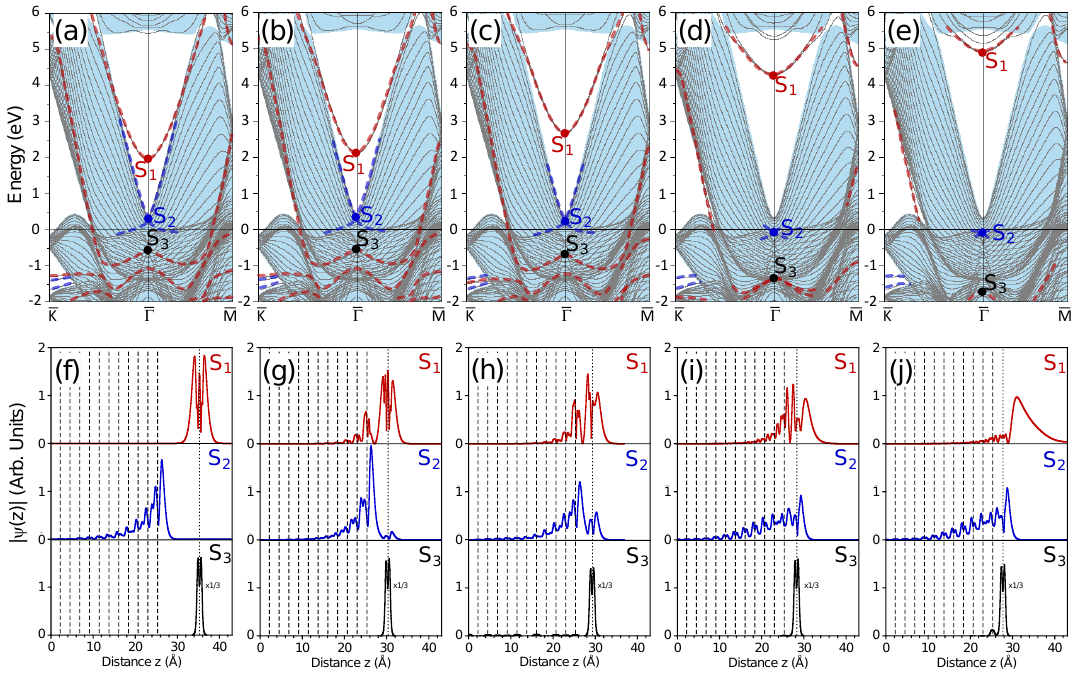
Figure 1. Electronic structure of the one monolayer (ML) Au/Pt(111) surface at ( a ) 10 Å, ( b ) 5 Å, ( c ) 4 Å, ( d ) 3 Å, and ( e ) the equilibrium distance between the top Pt and Au atomic layers. The surface states discussed in the text are marked as S 1 , S 2 , and S 3 . Panels ( f – j ) present respectively the in-plane averaged charge density distributions of the S 1 (red), S 2 (blue), and S 3 (black) surface states. In ( f – j ), vertical dashed (dotted) lines show the positions of the Pt (Au) atomic layers. The central atomic layer of the 23 ML Pt slab is placed at